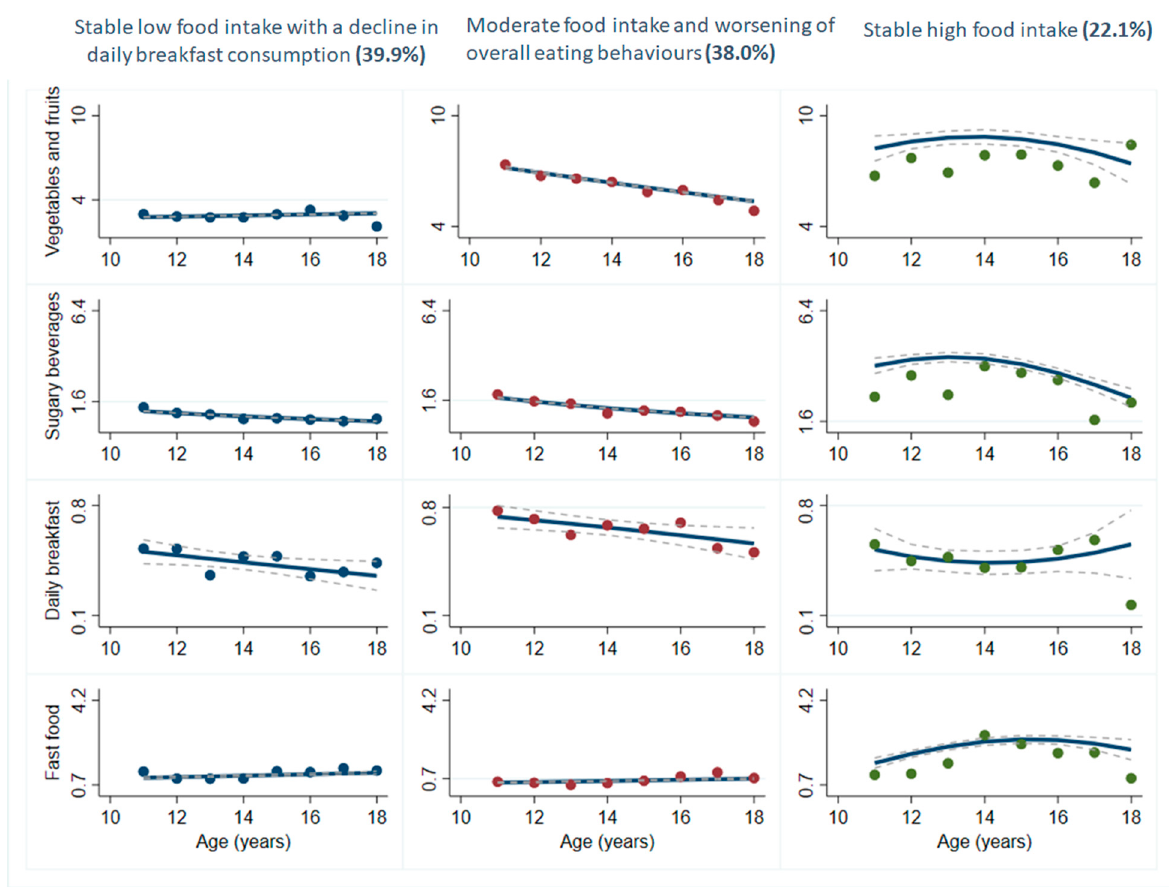
Figure 1. Multi-trajectory modelling of four eating behaviours among adolescent girls in the MATCH study. Figure caption: MATCH: Monitoring Activities of Teenagers to Comprehend their Habits. A dashed line represents the 95% confidence interval. Solid lines represent the average frequency of daily intakes for vegetables and fruits, sugary beverages and fast food, and the probability of daily breakfast consumption.